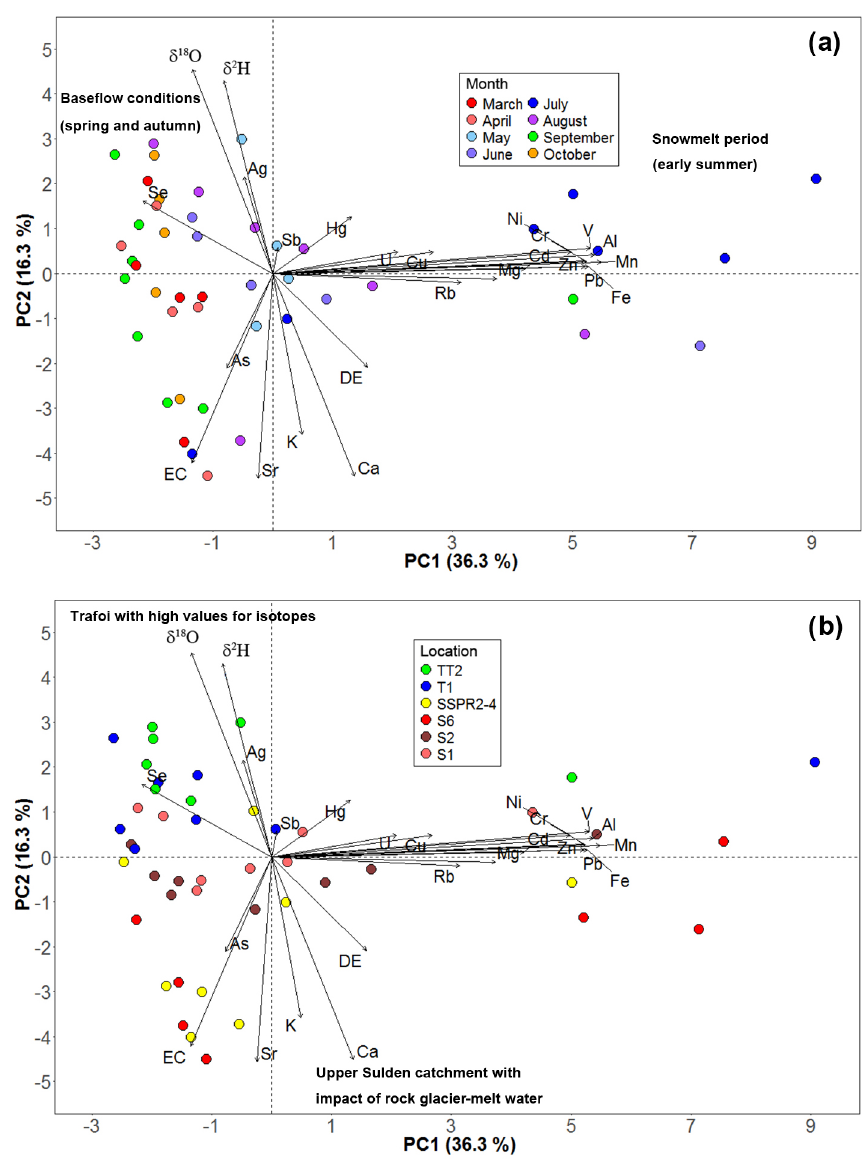
Figure 2. Principle component analysis of element concentrations of stream water and springs draining a rock glacier sampled in the Sulden and Trafoi sub-catchments from March to October 2015. Data based on n = 47 samples are shown in groups according to (a) the sampling locations and (b) the sampling